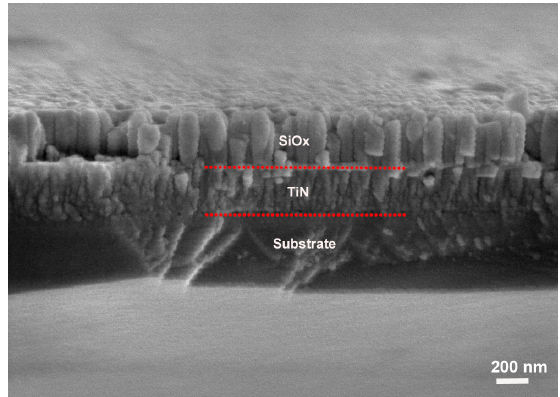
Figure 4. Cross-sectional SEM image of the TiN/SiO x duplex coating.